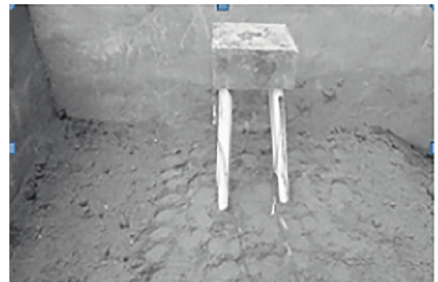
Figure 4: Layout of the model pile in